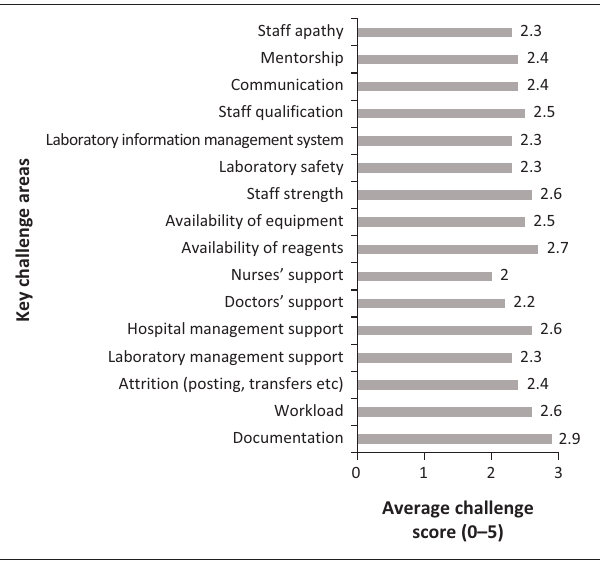
FIGURE 1: Scoring of key challenges to accreditation by laboratory staff at the Pathology Division Laboratory, 37 Military Hospital, Accra, Ghana, November